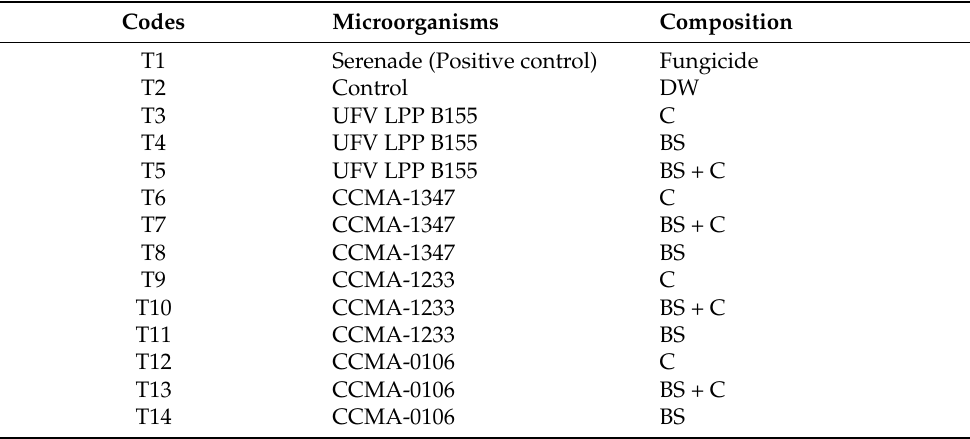
Table 2. Treatments evaluated for the inhibition of uredospores germination. Codes Microorganisms Composition T1 Serenade (Positive